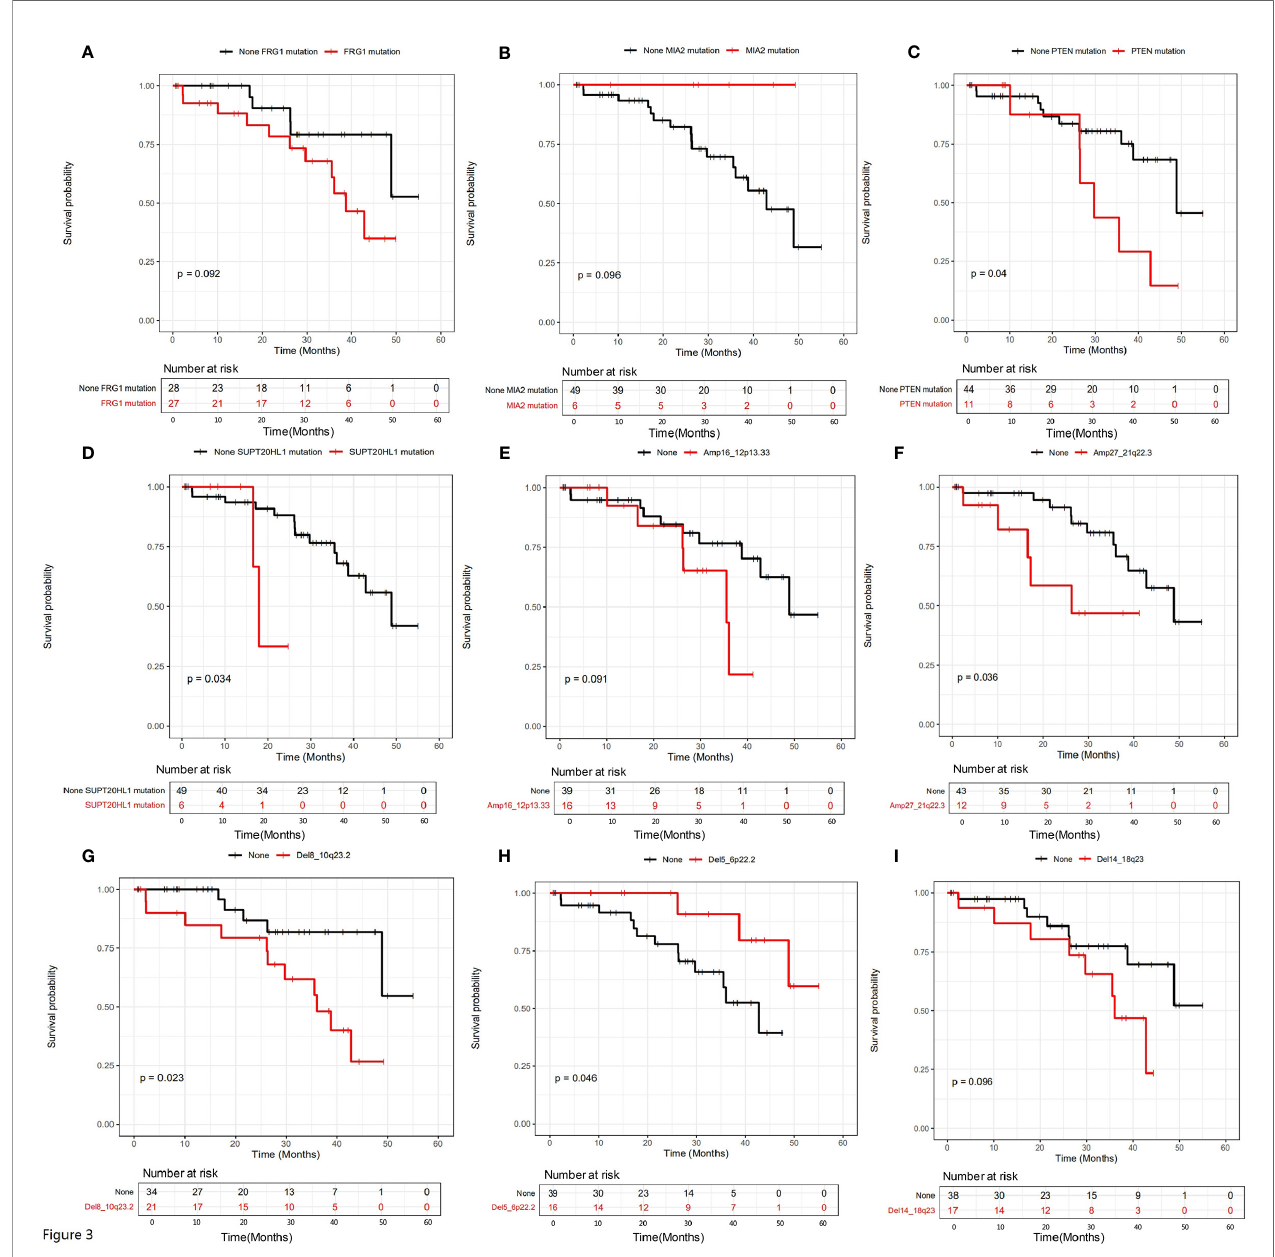
FIGURE 3 | The in fl uence of genetic variations on the prognosis of all patients involved in this study. The in fl uence of a series of SNV/INDEL mutations were shown in (A – D) , the in fl uence of CNV variations including a series of ampli fi cations and deletions were shown in (E – I) . Gene names were